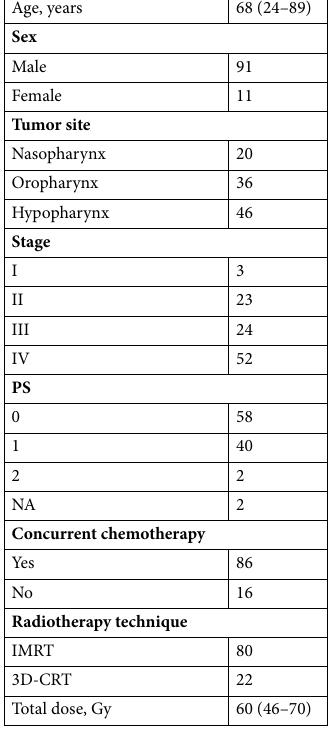
Table 1. Patient characteristics. Values are number or median (range). IMRT intensity-modulated radiotherapy, 3D-CRT 3-dimensional conformal